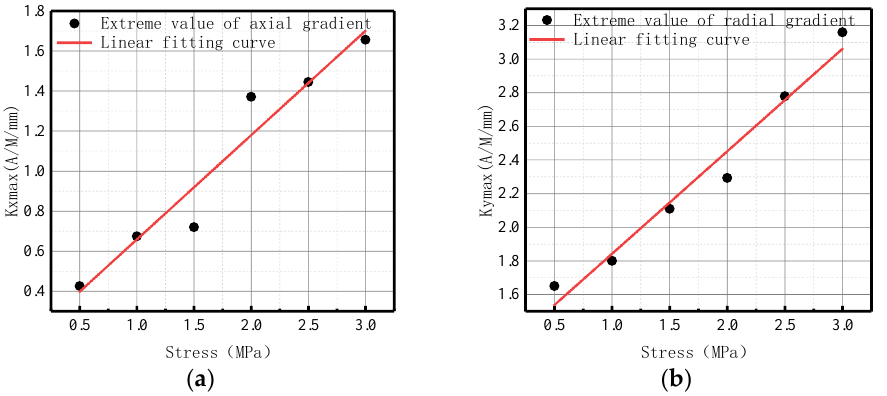
Figure 28. Variations of Kmax at the weld under different internal pressures. ( a ) Axial component of Kmax ; ( b ) radial component of Kmax .